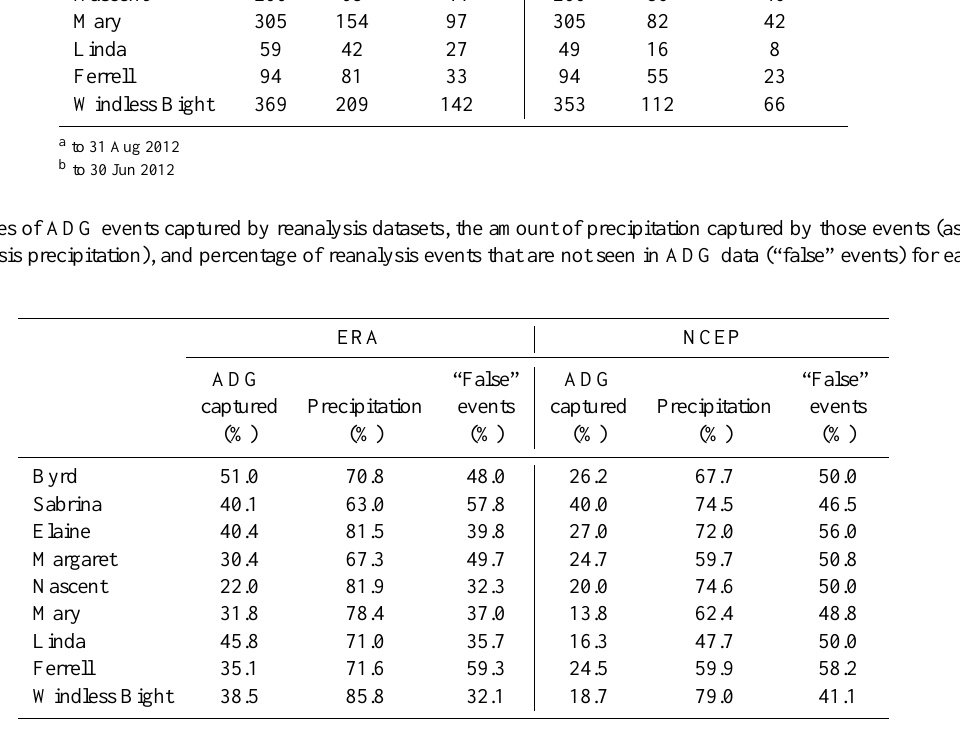
Table 2. The number of events for ADG, ERA-Interim, and NCEP-2 datasets and number of coincident events. Number of Events ADG a ERA